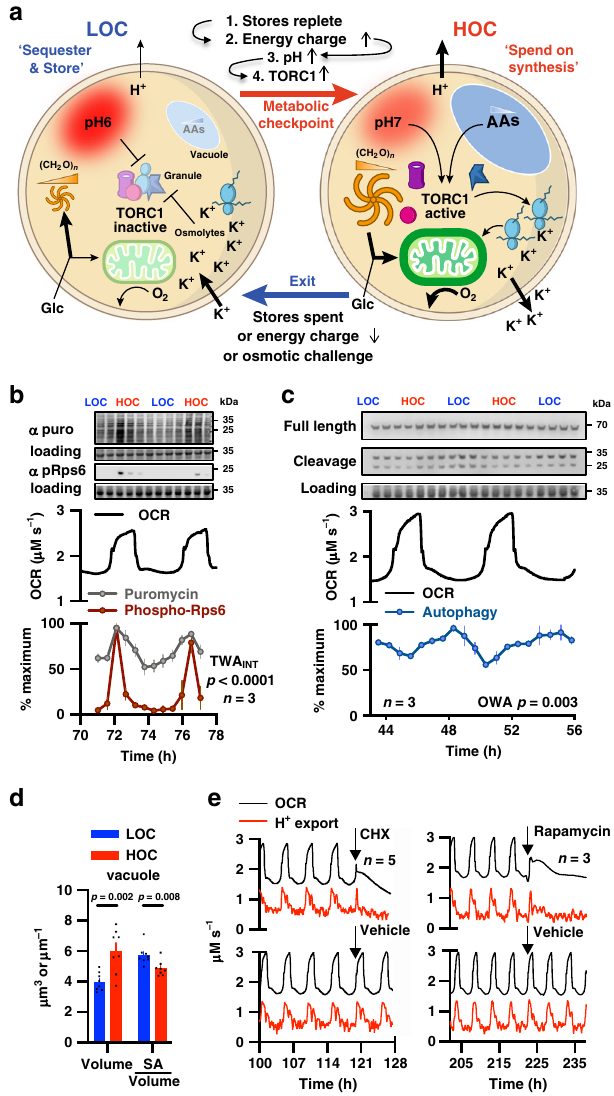
Fig. 3 Switching occurs between protein synthesis (HOC) and autophagy (LOC). a Model: cells accumulate carbohydrates (CH 2 O) n , amino acids and osmolytes during LOC and consume/export them in HOC to sustain translational bursts and maintain osmostasis. Replete stores increase H + export, a pH-dependent checkpoint activating TORC1 and releasing BMC proteins. HOC ends when stores are exhausted, see Fig. 5e and Supplementary Table 1 for more details. b Puromycin incorporation assay and immunoblot for TORC1 activation (phospho-Rps6, Ser235/236) reveal translational bursting in HOC ( n = 3 biologically independent samples, TWA INT : two-way ANOVA INTERACTION, total protein loading control). c Immunoblots for cleaved/full-length Pgk1-GFP reveal increased autophagy during LOC ( n = 3 biologically independent samples, OWA one- way ANOVA, total protein loading control). d Differential variation in vacuole volume vs. surface area:volume ratio (two-sided unpaired t -test, n = 7 independent experiments for HOC and LOC, n > 68 cells per image). Data throughout presented as mean ± SEM where * p ≤ 0.05, ** p ≤ 0.01,